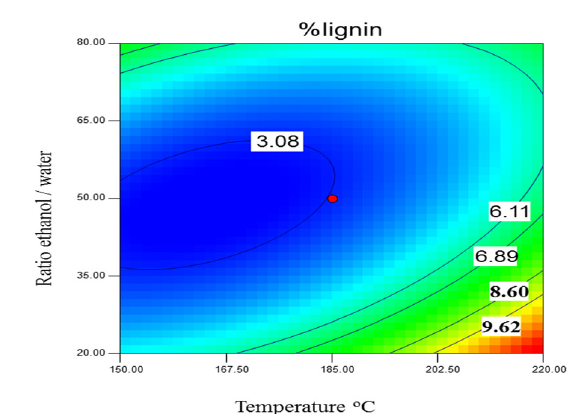
Fig. 6. (Effect of temperature and ratio on lignin percent at constant time 80